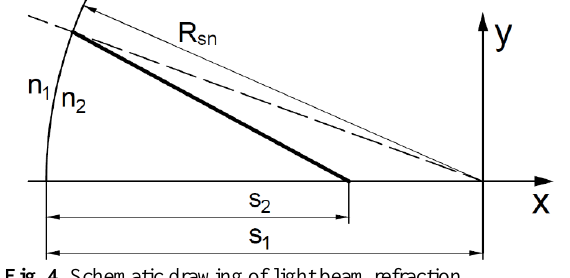
Fig. 4. Schematic drawing of light beam refraction Zhang in [16] determined a location recalculation, which is appropriate for using the LDA system.